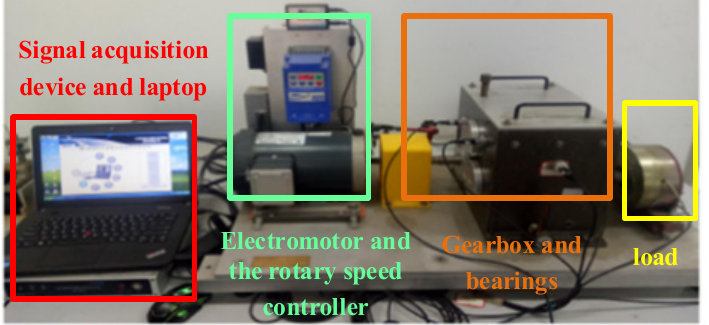
Figure 14. Gearbox experimental platform.